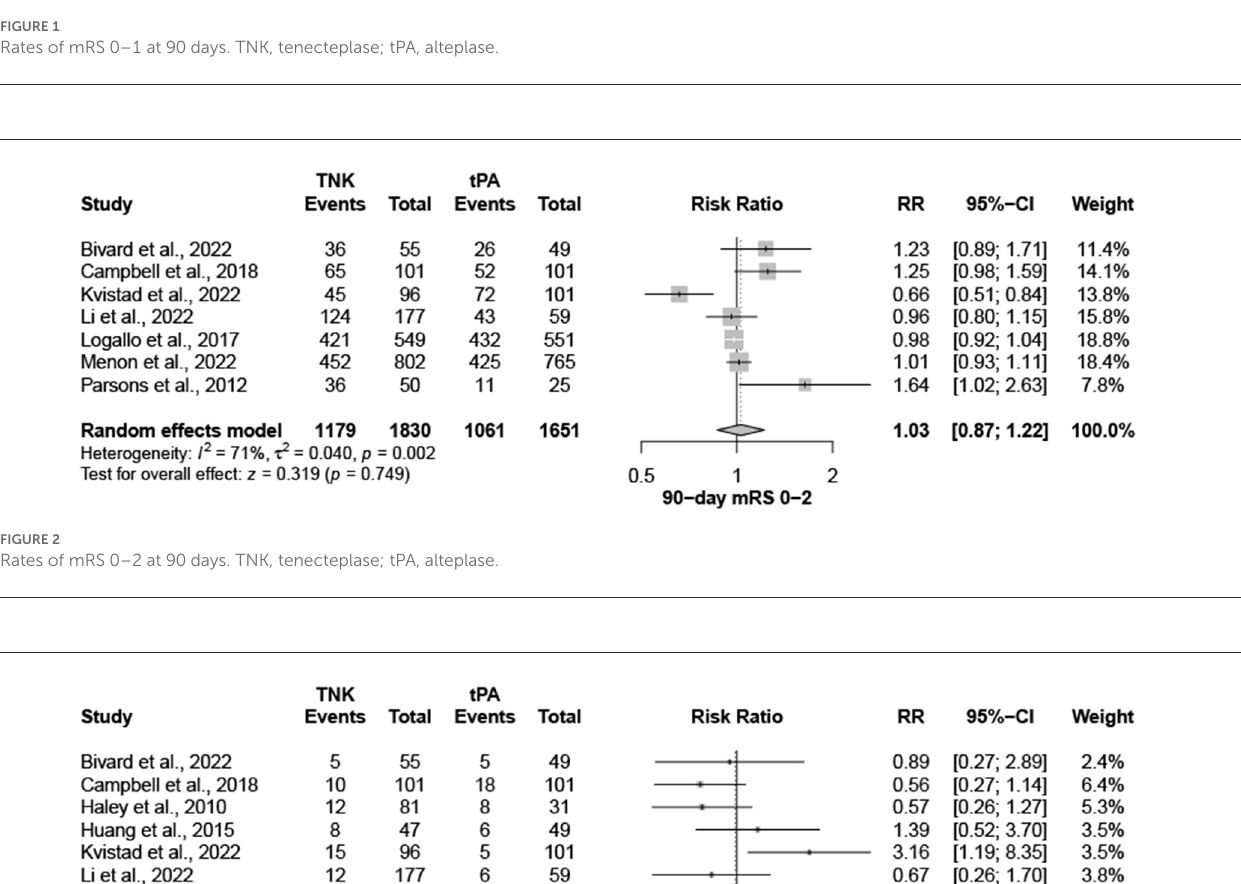
95% CI = 0.75–1.61; P -value = 0.622) were comparable in both treatment groups (Figure 3). There was no significant heterogeneity among included studies in either mortality (I 2 = 30%; P